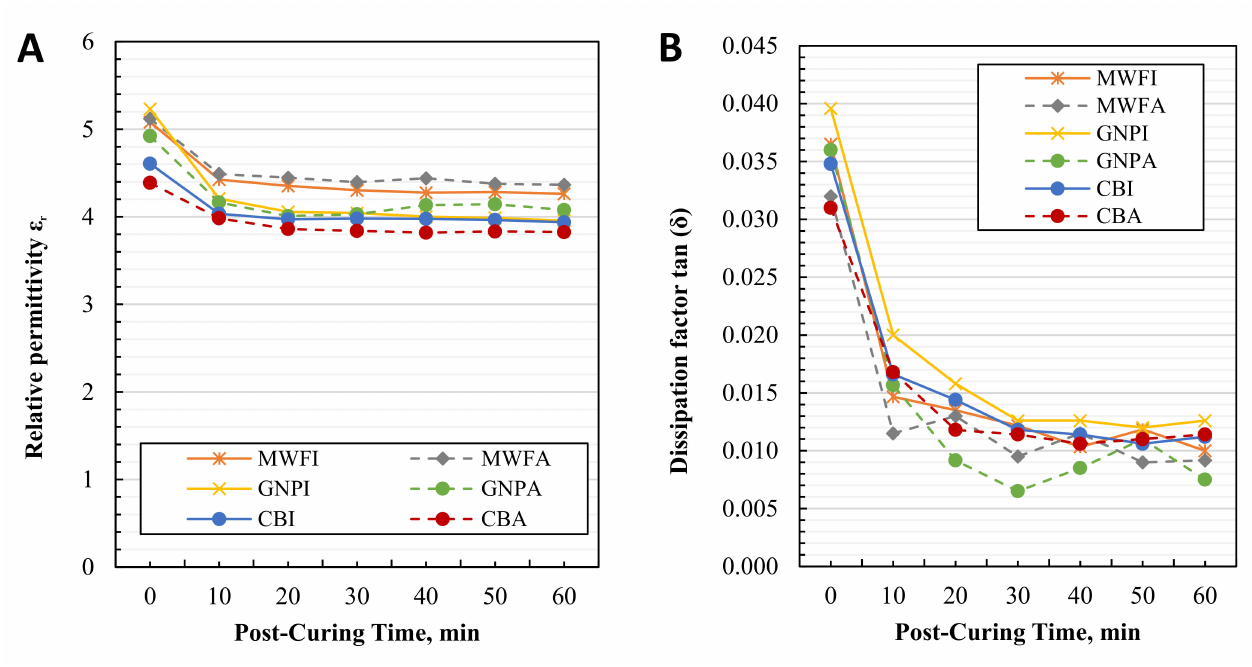
Figure 12. Results of post-cured 0.1 wt.% nanomaterial/photopolymer composite specimens: ( A ) change in relative permittivity ε r at 1 kHz; ( B ) change in dissipation factor tan ( δ ) at 1